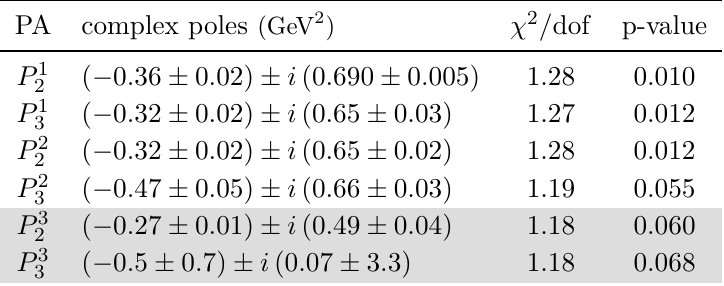
Table 1 . Complex poles of the Padé approximants used as fitting functions to the Landau-gauge gluon-propagator lattice data, together with the χ 2 / dof and the p-value of the respective fits. Results from P 3 ( p 2 ) and P 3 ( p 2 ) do not enter our final values (see 2 3